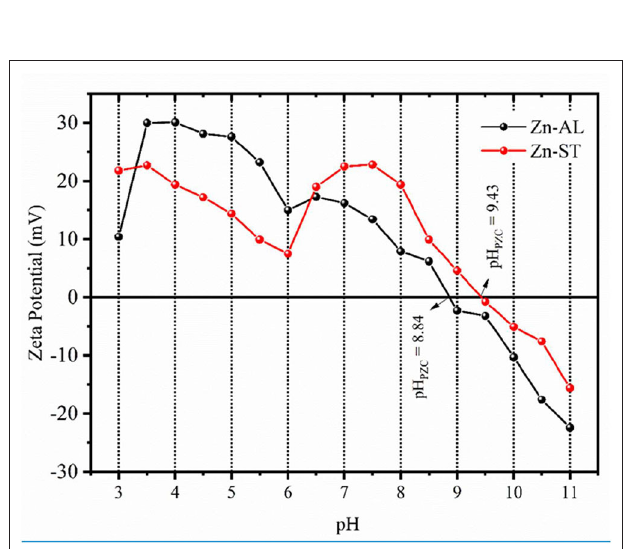
on pH, with percentage of removal > 95% for all evaluated pH, reaching the maximum adsorption at pH of 4 for